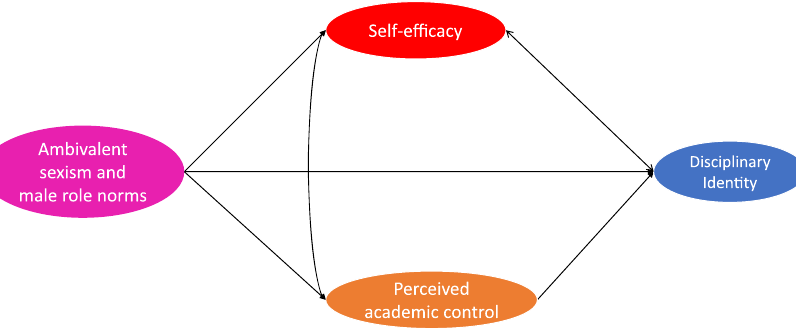
FIG. 1. Hypothesized model of relationships between gender stereotypes (ambivalent sexism and male role norms), self-efficacy, perceived academic control, and disciplinary